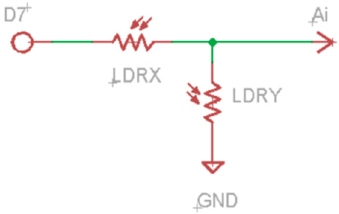
Figure 9. LDR Figure 9. LDR schematic. Figure 9. LDR schematic. Figure 9. LDR schematic.